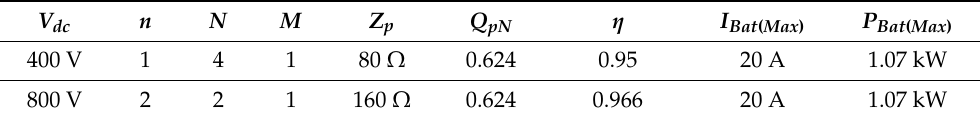
Table 2. Designs comparison.